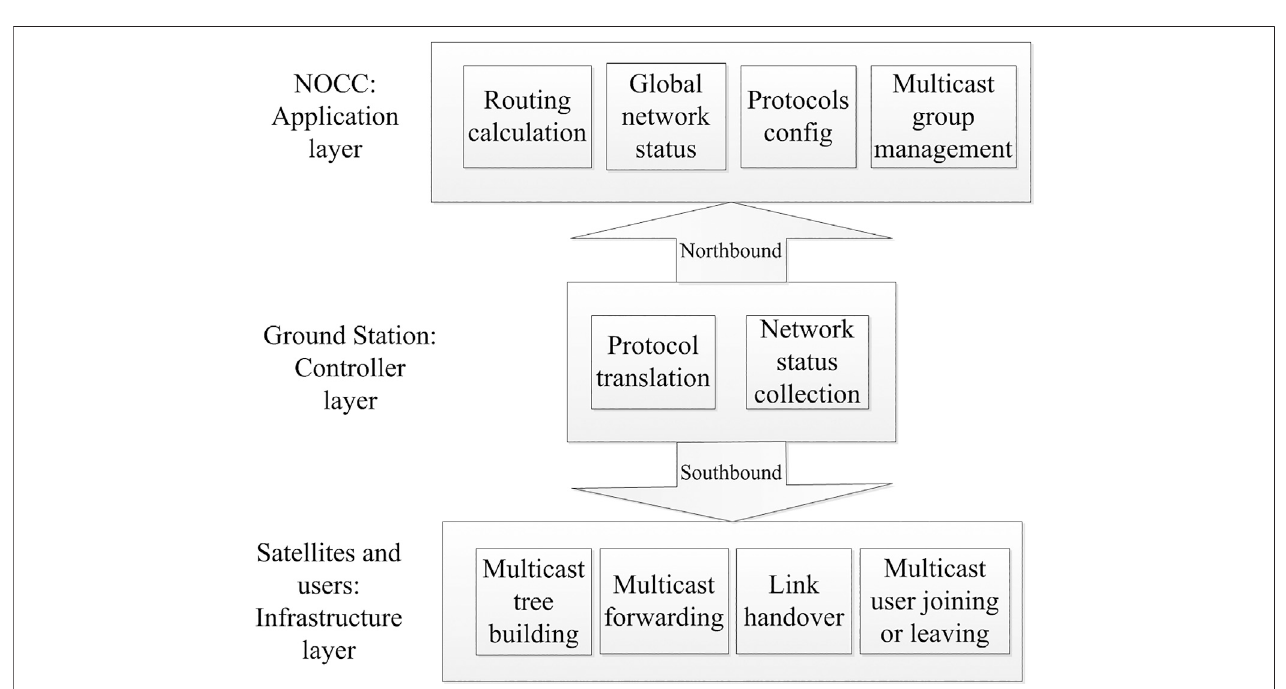
FIGURE 2 | The SDN